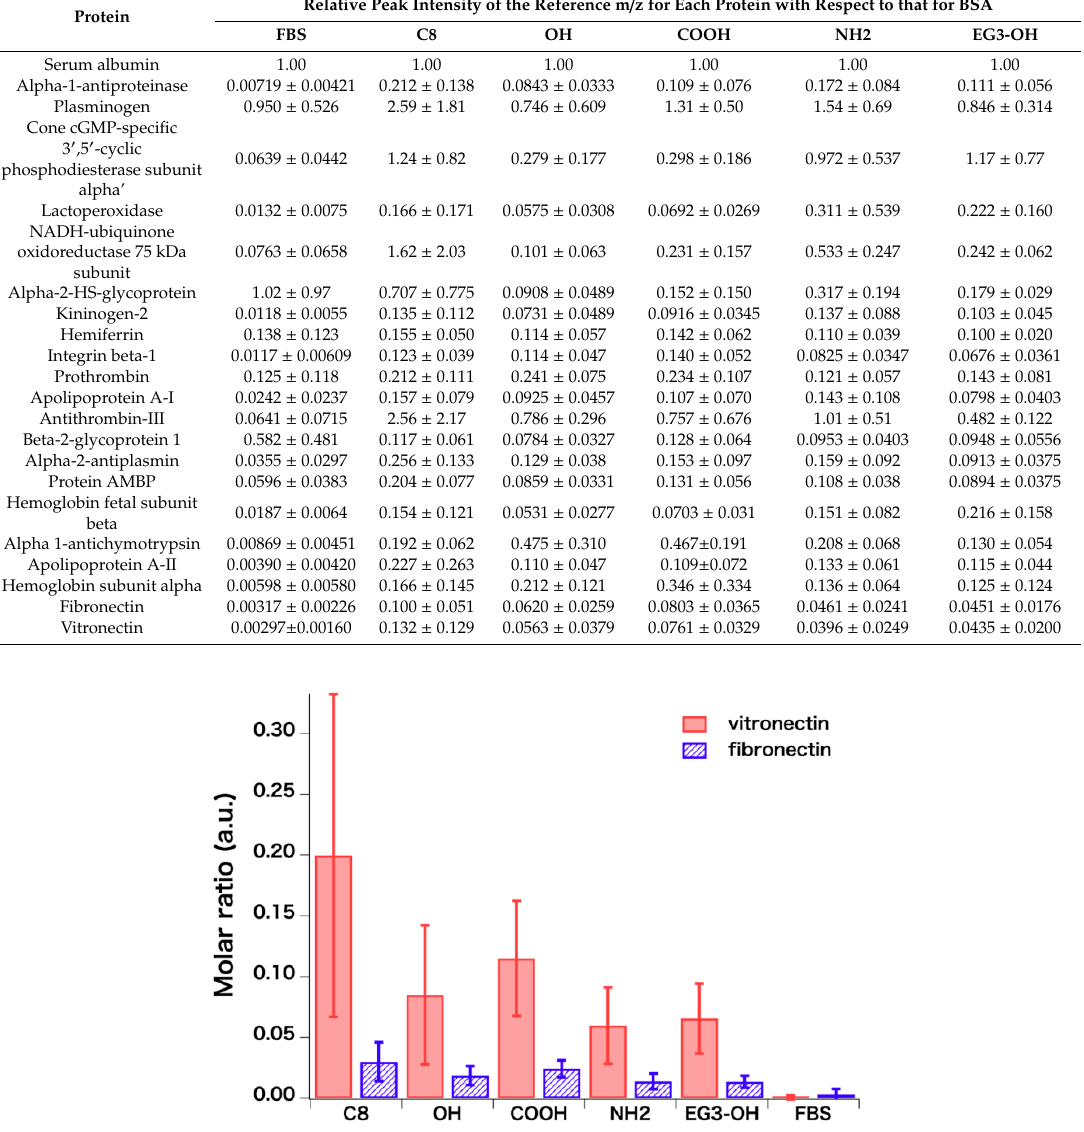
Figure 7. Evaluated molar ratios of vitronectin and fibronectin with respect to BSA ( n = 30). Error bars and n denote standard deviation and the number of spectra analyzed, respectively.